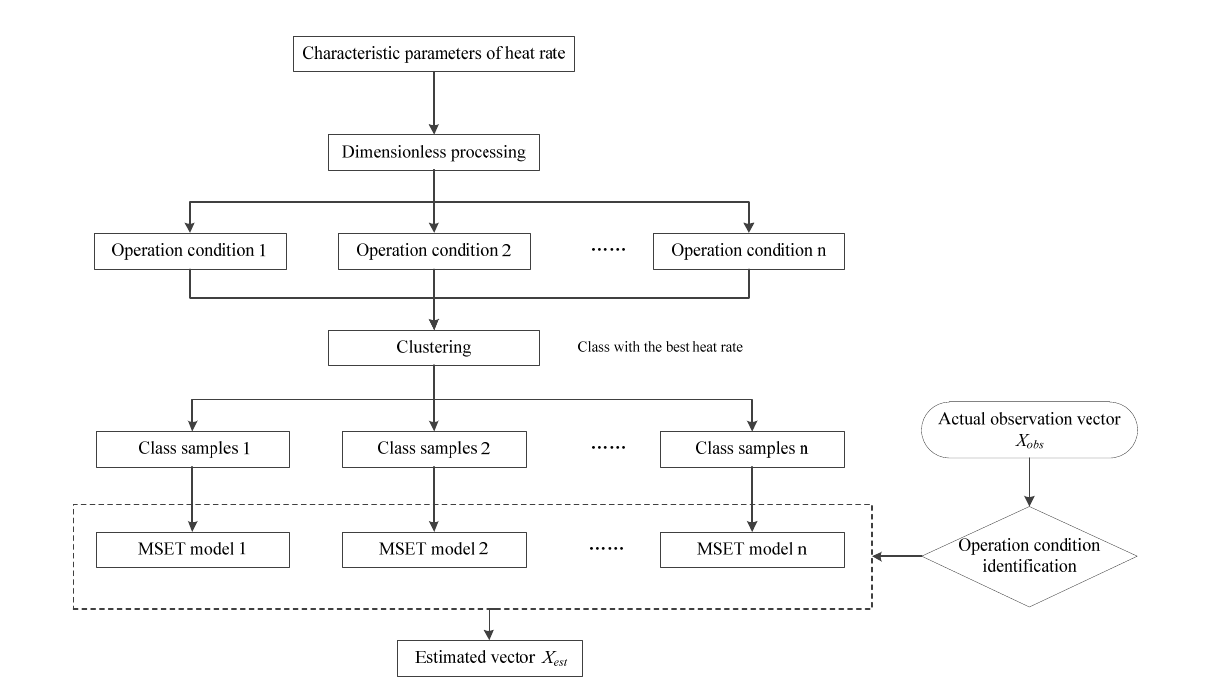
Figure 4. The flow chart for establishing heat rate MSET model. Table 4. Clustering results by Kmeans method.